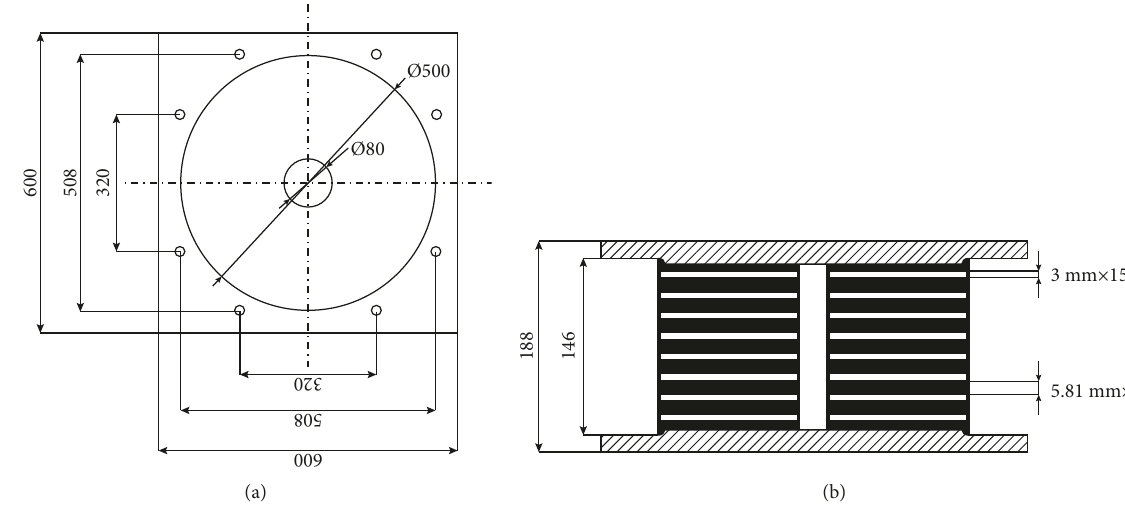
Figure 19: Dimensional drawing of LNR500.